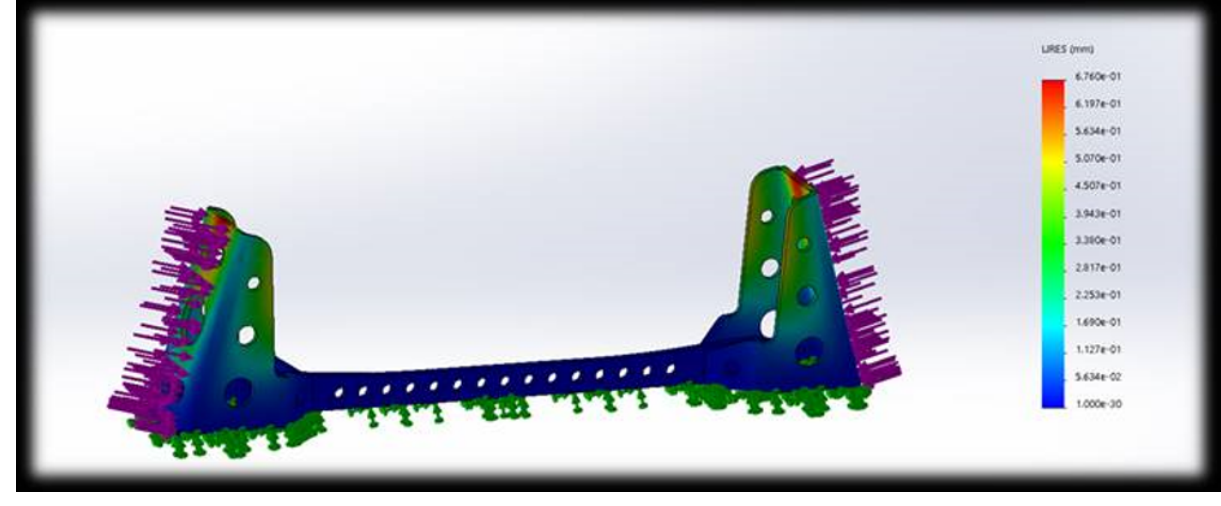
Figure 7: Deformation simulation of front axle 2018.